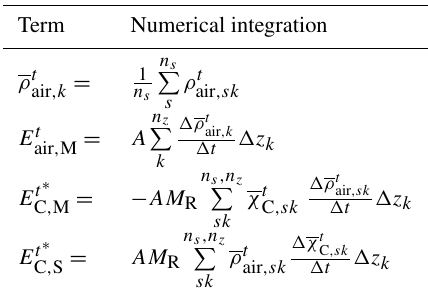
Table B3. Discrete integral expressions for Eqs. (13)–(15) to be substituted in Eq. (16) for TR ∗ method estimations. t is the time index; s and k are the horizontal and vertical space indices along the screens, respectively. A is the box base area.